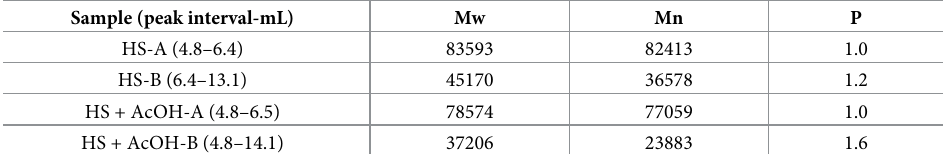
Table 3. Weight average (Mw) and number average (Mn) molecular weights, and polydispersity (P), as calculated from UV-detected HPSEC chromatograms for HS-FEN, before and after addition of acetic acid (AcOH). Standard deviation was <